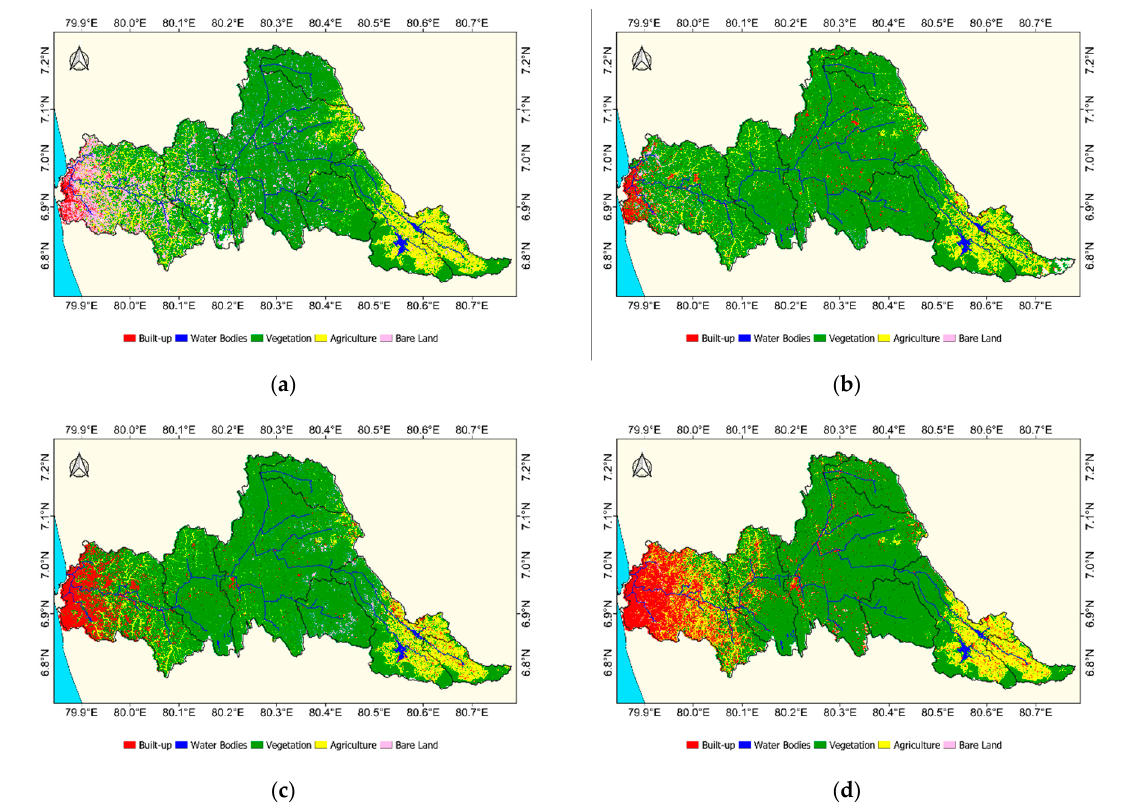
Figure 2. Land-use land cover maps of Kelani River Basin: ( a ) for 1988; ( b ) for 1998; ( c ) for 2008; ( d ) for 2018.